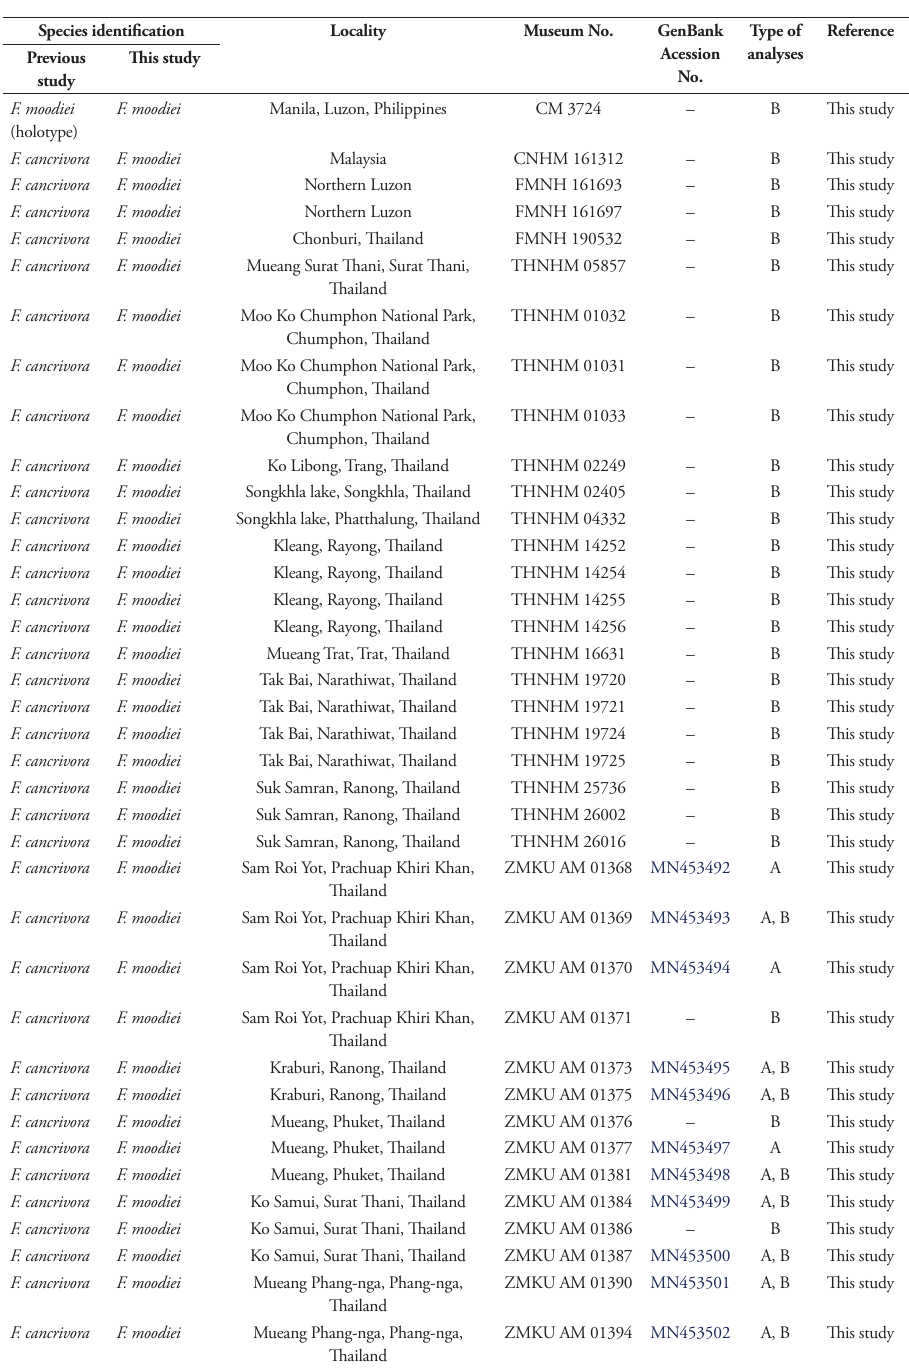
Table 1. Specimens of Fejervarya used in (A) molecular and/or (B) morphological analyses. Species